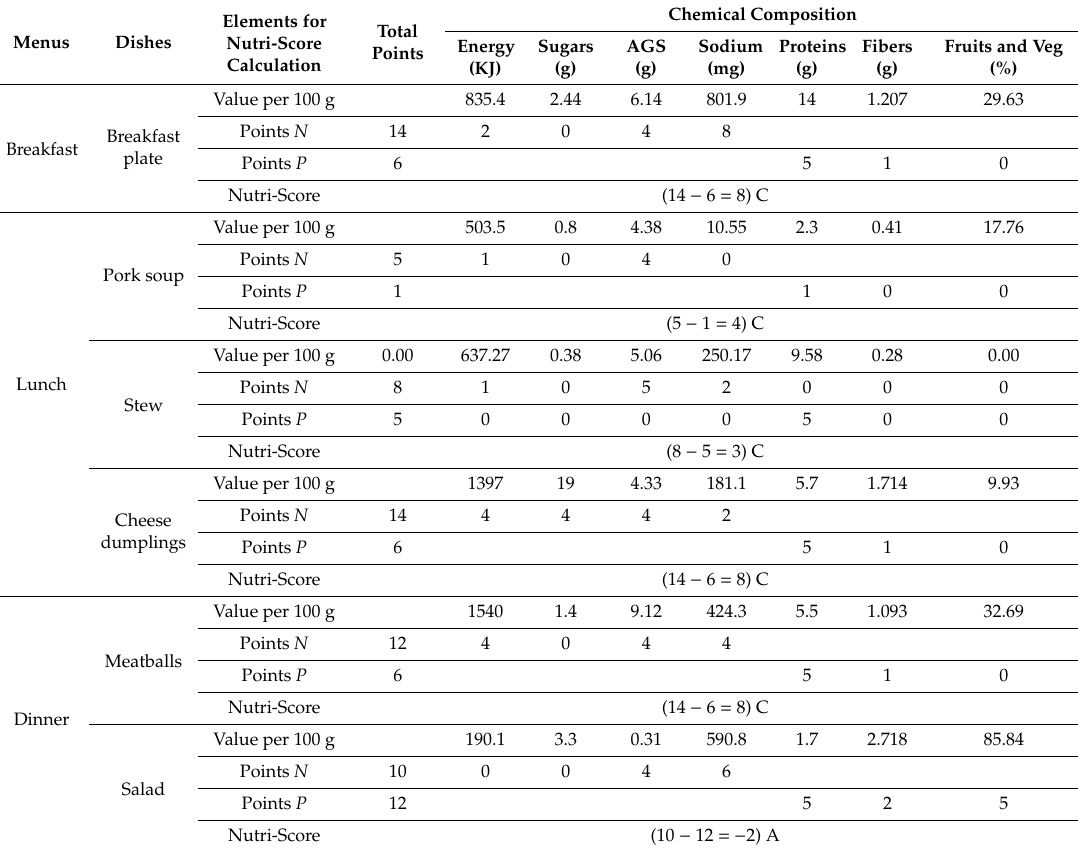
Table 3. Summary results of the Nutri-Score